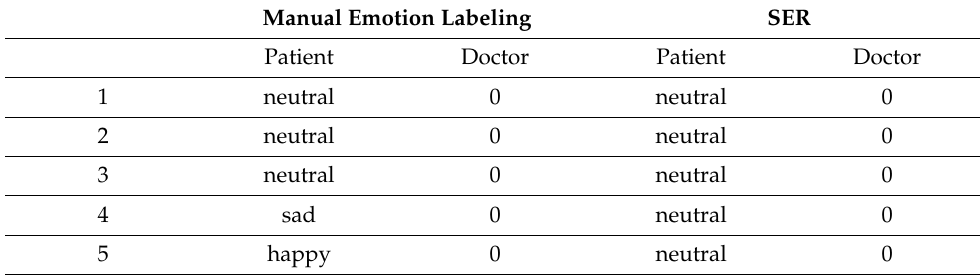
Table 3. Comparison between manual emotion labeling and SER. Overlapping speech of multiple individuals in clinics is labeled “x”; “0” indicates that the speech does not belong to particular Table 2. SER model emotion categorization results on all the data sets (90.2% accuracy). speaker